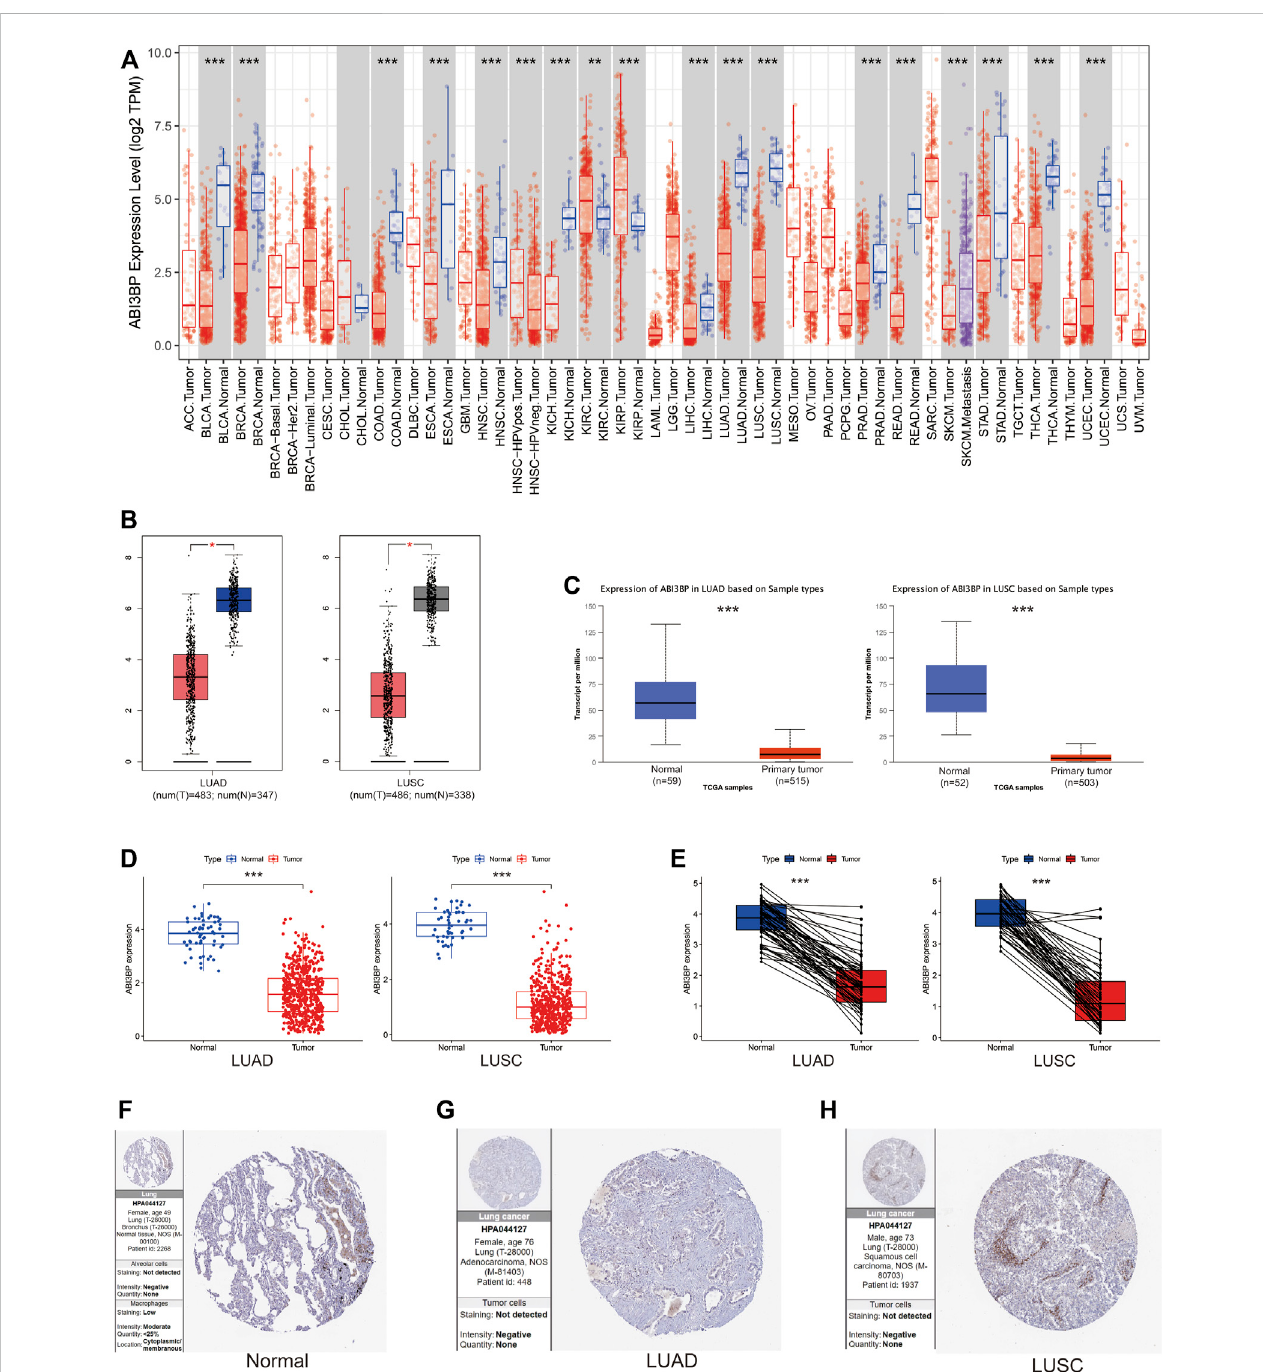
FIGURE 1 ExpressionofABI3BPinlungtumors. (A) TheexpressionofABI3BPindifferenttypesofcancerwasanalyzedusingTIMERrepository. (B) Theexpressionof ABI3BP in regular and lung cancerous tissues was examined using GEPIA. (C) The expression of ABI3BP in lung cancerous tissues and normal tissues was analyzed using UALCAN. (D) The expression of ABI3BP in lung tumor and regular lung tissue was analyzed using TCGA database. (E) Paired expression of ABI3BP in lung tumors was analyzed using TCGA. The expression level of ABI3BP in normal lung tissue (F) , LUAD tissue (G) , and LUSC tissue (H) was detected in the HPA database. *, p < 0.05 **, p < 0.01 ***, p <